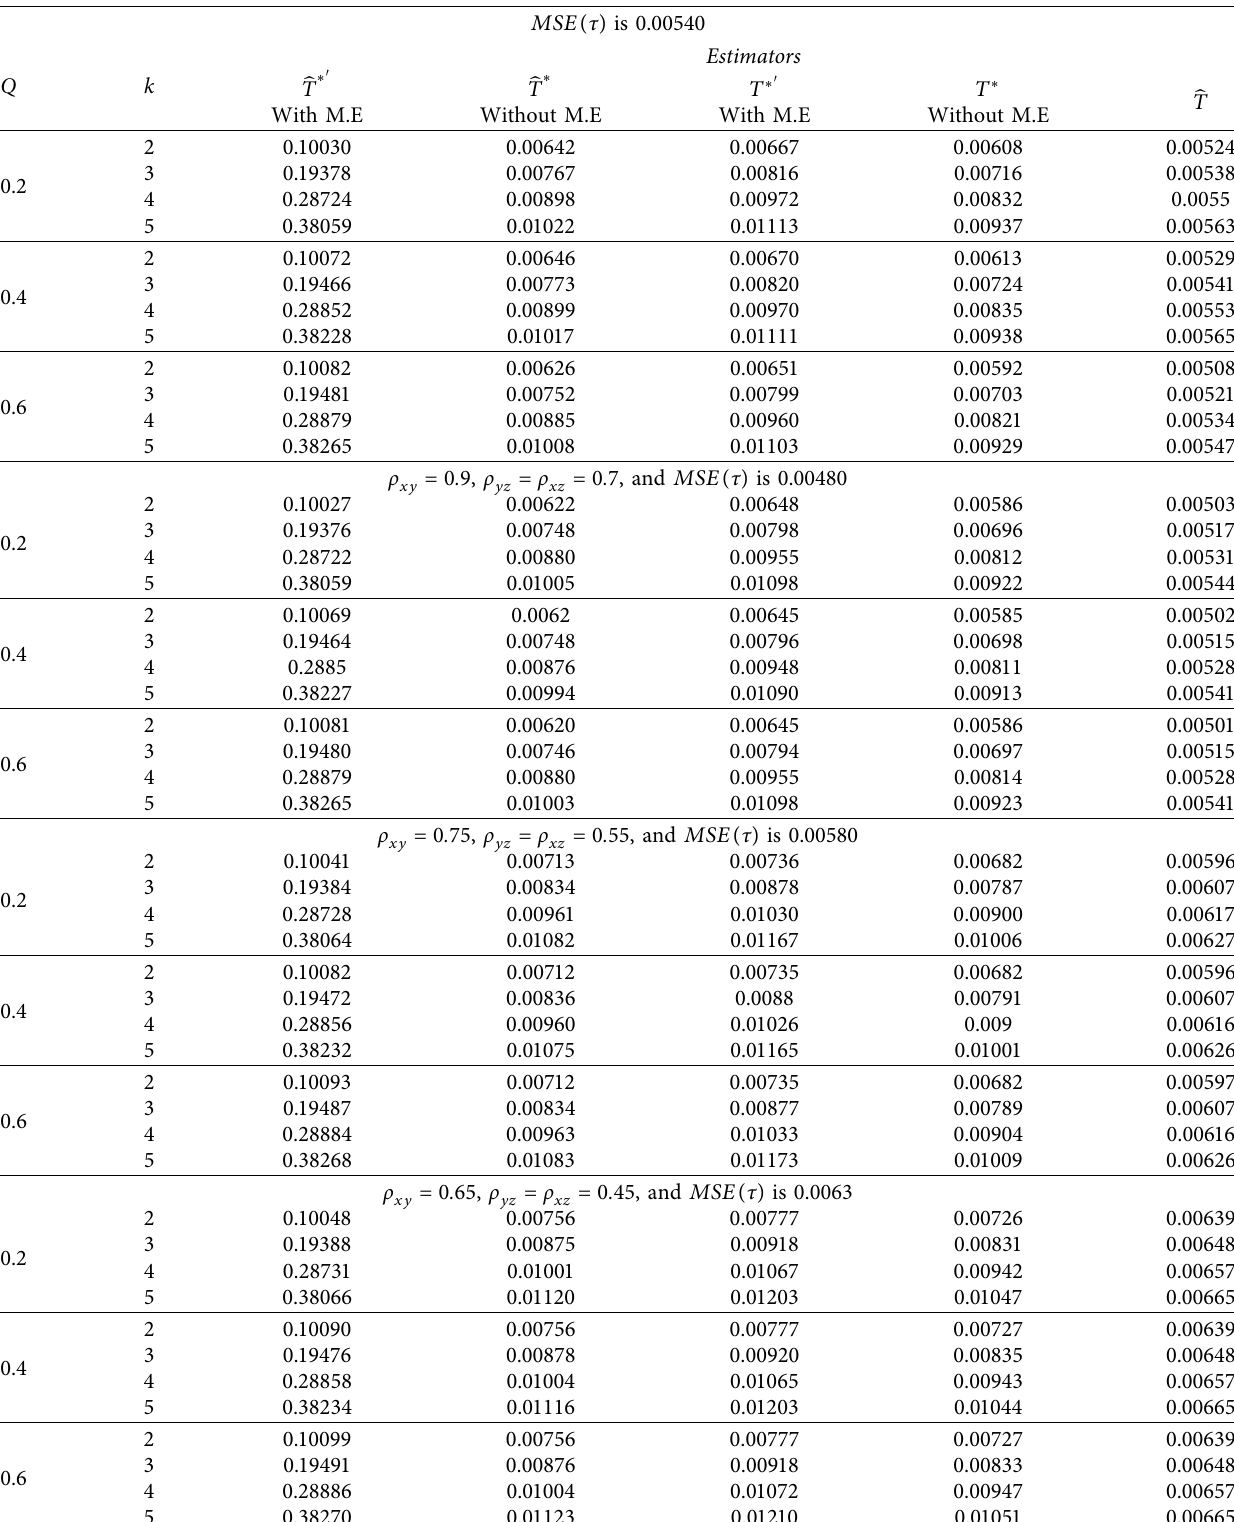
Table 2: MSE of the proposed estimators with nonresponse and measurement errors for W � 0 . 8 and diferent values of k and q